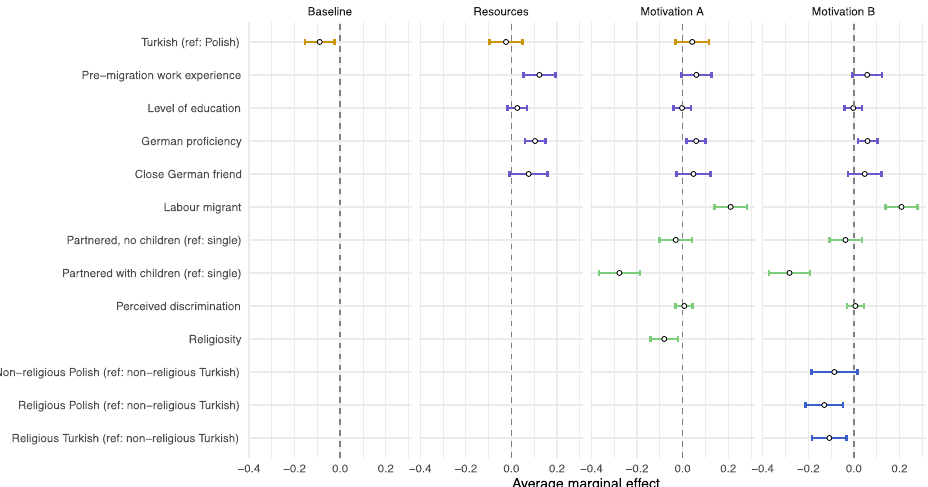
Figure 2 : Predictors of recent female migrants’ labour force participation in Germany (logistic regressions -